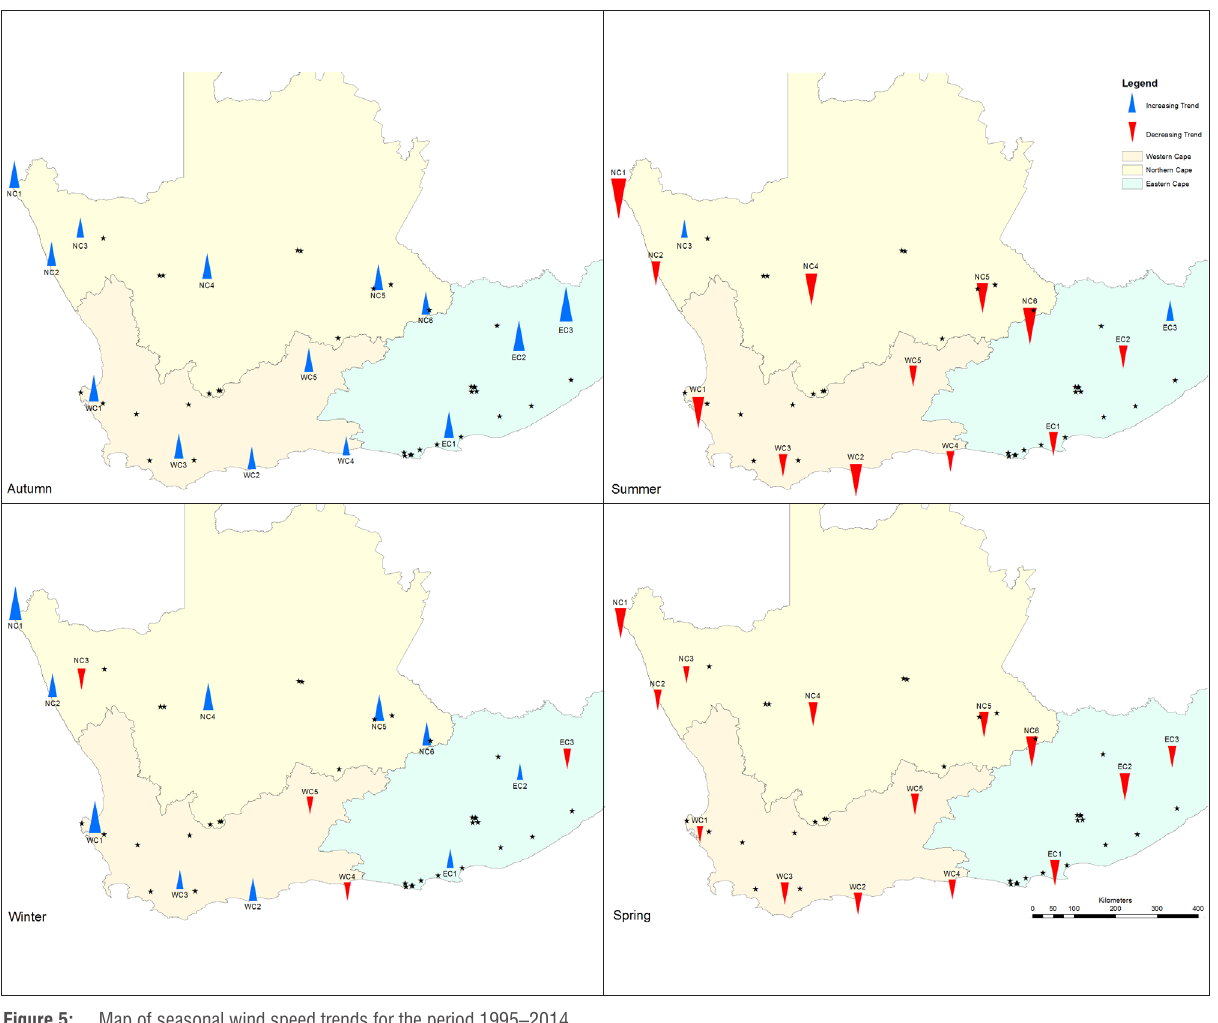
Figure 5: Map of seasonal wind speed trends for the period 1995–2014.